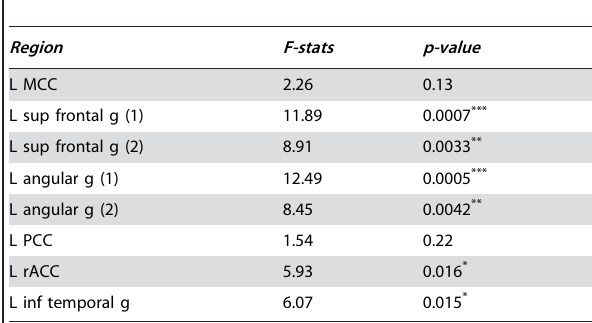
Table 3. Tests of group differences in the cumulative measure of the BOLD signal related to semantic processing in the 6–14 s post-stimulus period within each